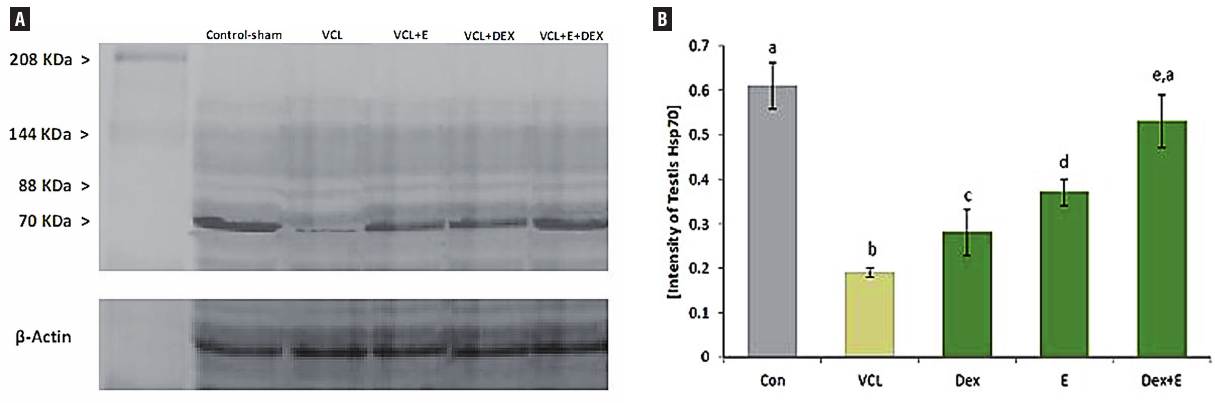
Figure 7 - Western blot analyze for Hsp70-2 protein expression in testicular extract. The VitE (150 mg/kg) and DEX (0.125 mg/kg) alone and simultaneous administration enhanced the Hsp70-2 protein expression as there is no significant difference (P>0.05) between VitE+DEX-treated animals with control-sham group.